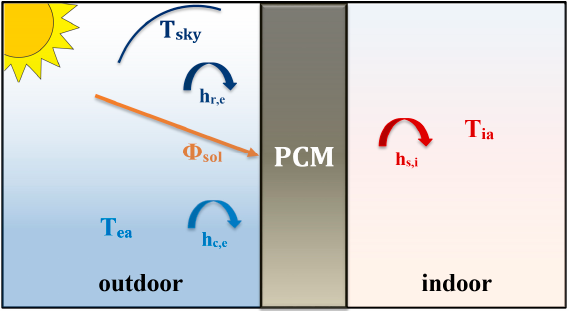
Figure 1. Thermal exchanges schematization on the external and internal surface of the phase change material (PCM) layer.